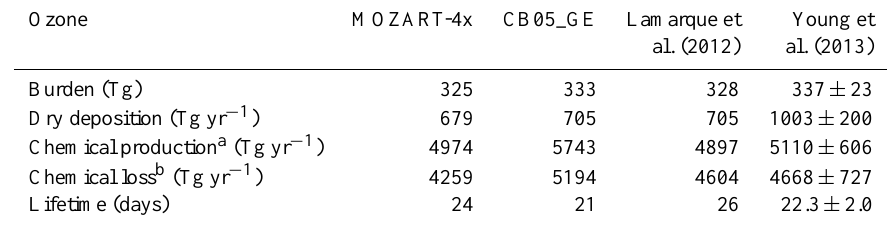
Figure 8. (a) Absolute differences averaged during 2008–2010 in tropospheric column concentrations of major gaseous species between MOZART-4x and CB05_GE. (b) Absolute differences averaged during 2008–2010 in tropospheric column concentrations of major aerosol species between MOZART-4x and CB05_GE. Table 5. Tropospheric ozone